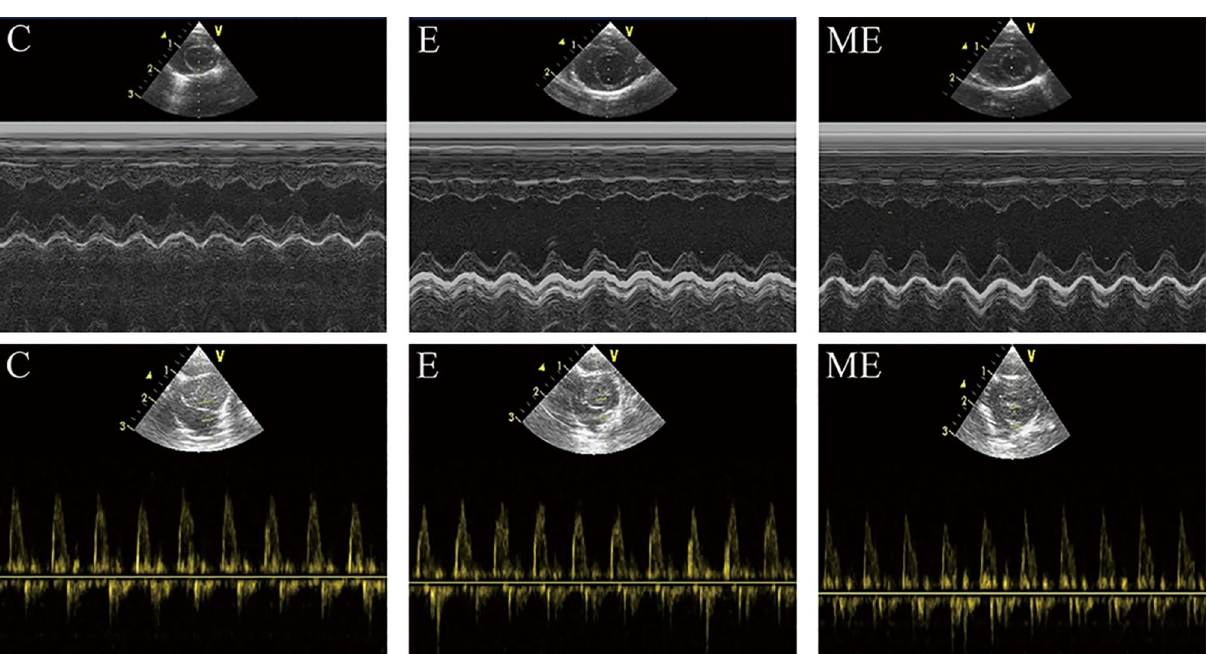
Figure 4. Changes of M-mode echocardiogram. The blood flow Doppler test records the ratio (E/A) of the peak blood flow velocity E in early diastole and the peak blood flow velocity A in late